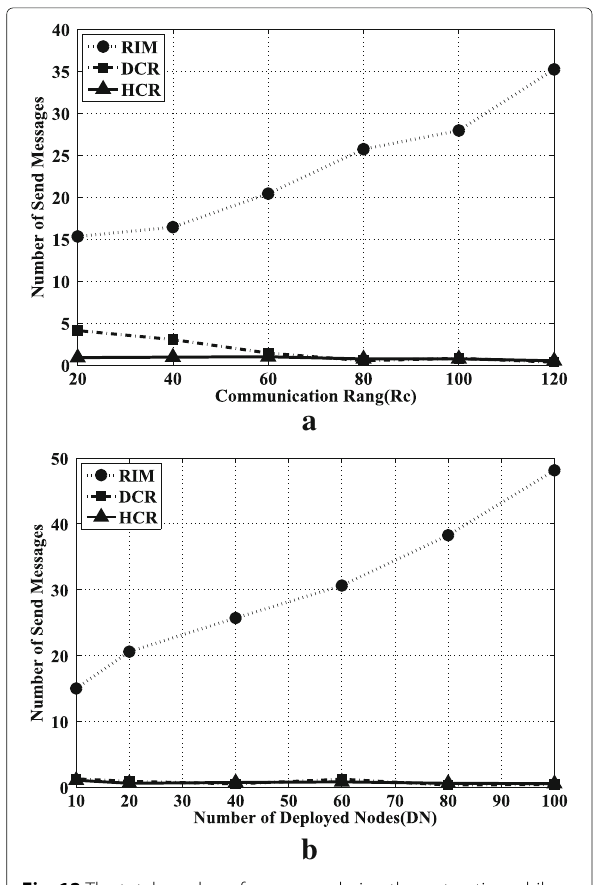
Fig. 12 The total number of messages during the restoration while varying a the communication range (with DN = 40) and b the network size (with R c =